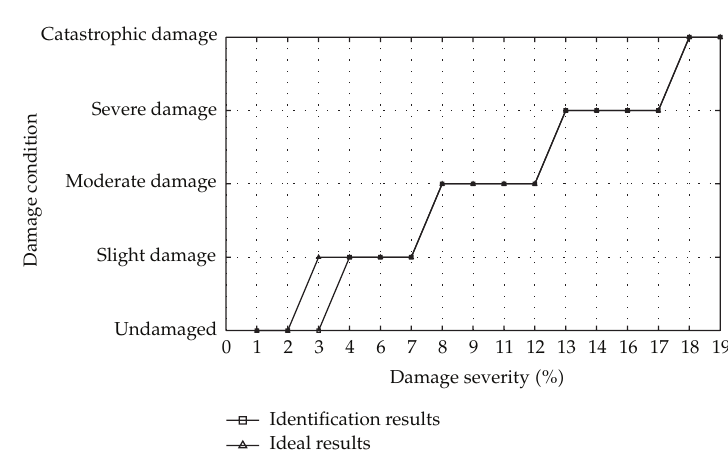
Figure 10: Identification results of fuzzy nearness-based method with incomplete